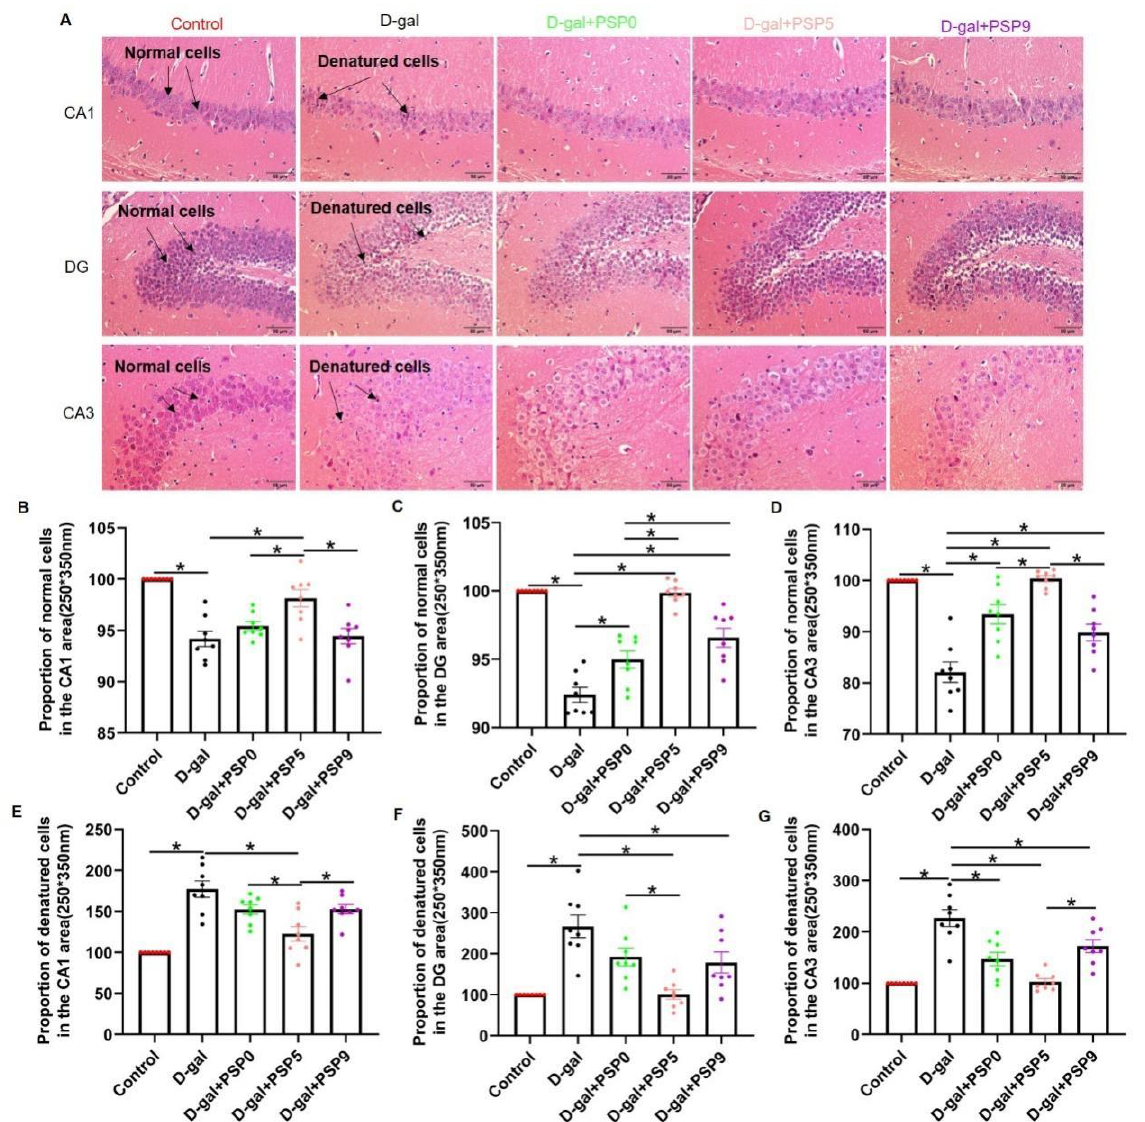
Figure 4. Steamed PSPs prevent the loss and degeneration of neurons in the hippocampal CA1, DG, and CA3 regions. ( A ) Hematoxylin and eosin (H&E) staining in the hippocampal regions CA1, CA3, and DG (normal cells are round and intact with clearly visible nuclei; in contrast, degenerated cells are more heavily stained (pyknosis) and have blurred nucleocytoplasmic borders) (Magnification: x 200). ( B – G ) Normal cells and denatured cells in the hippocampal CA1, DG, and CA3 region ( n = 8). Data are expressed as means ± SEM. * p <